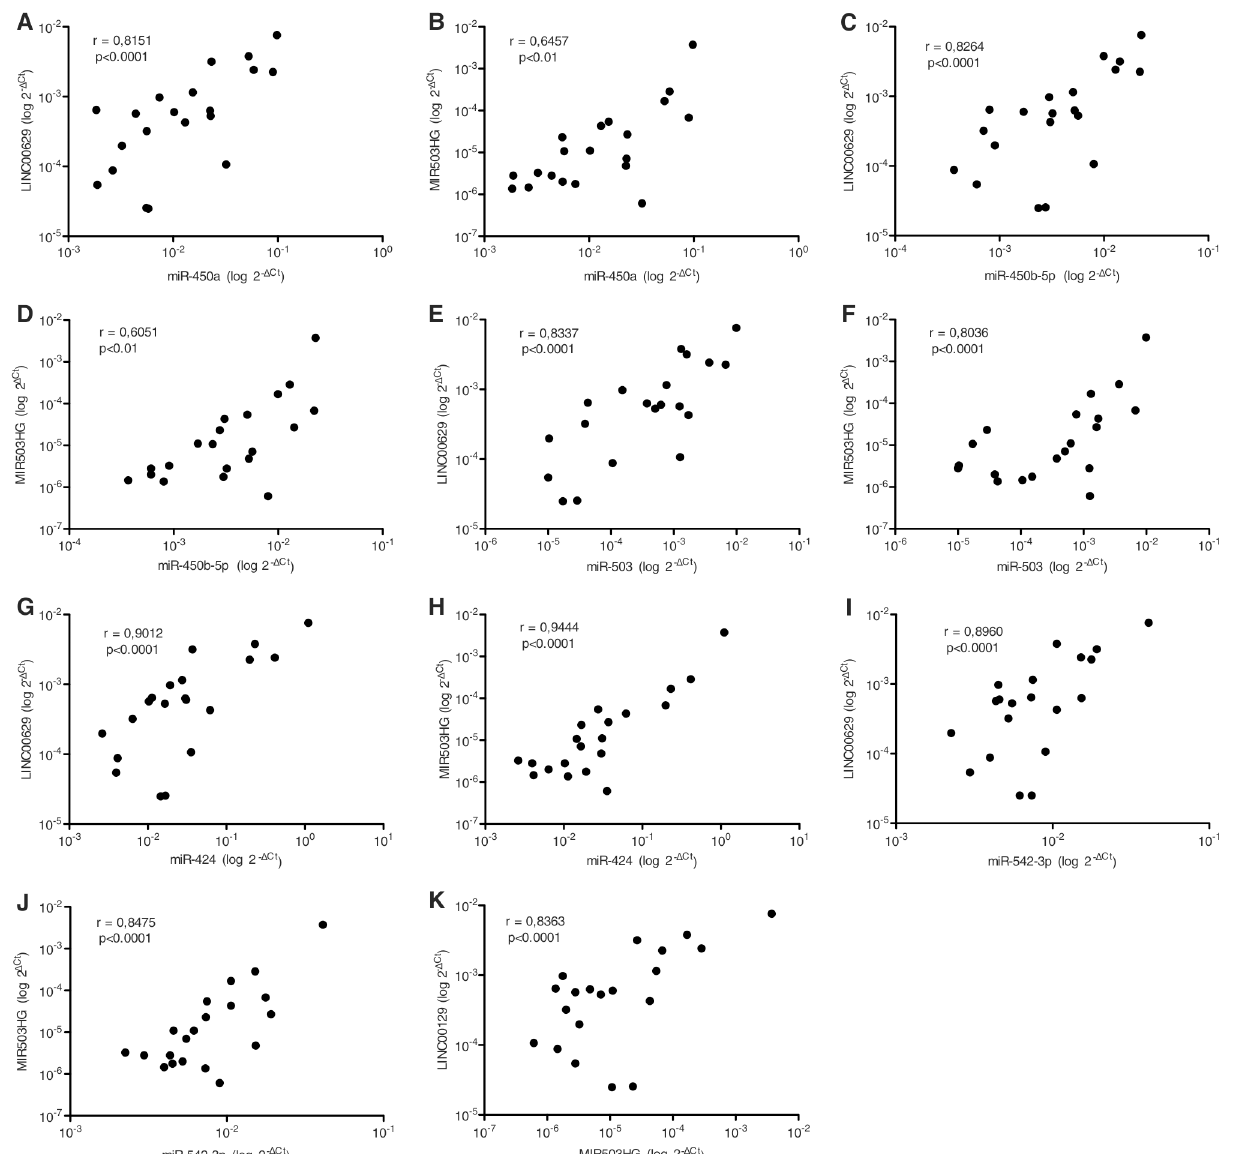
Fig 3. MIR503HG and LINC00629 lncRNAs expression are related to each other and to their neighboring microRNAs, in normal tissue panel. A-J. Pearson Correlation (r) test between one of the lncRNAs and a neighbor microRNA.K. Pearson Correlation (r) test between MIR503HG and LINC00629